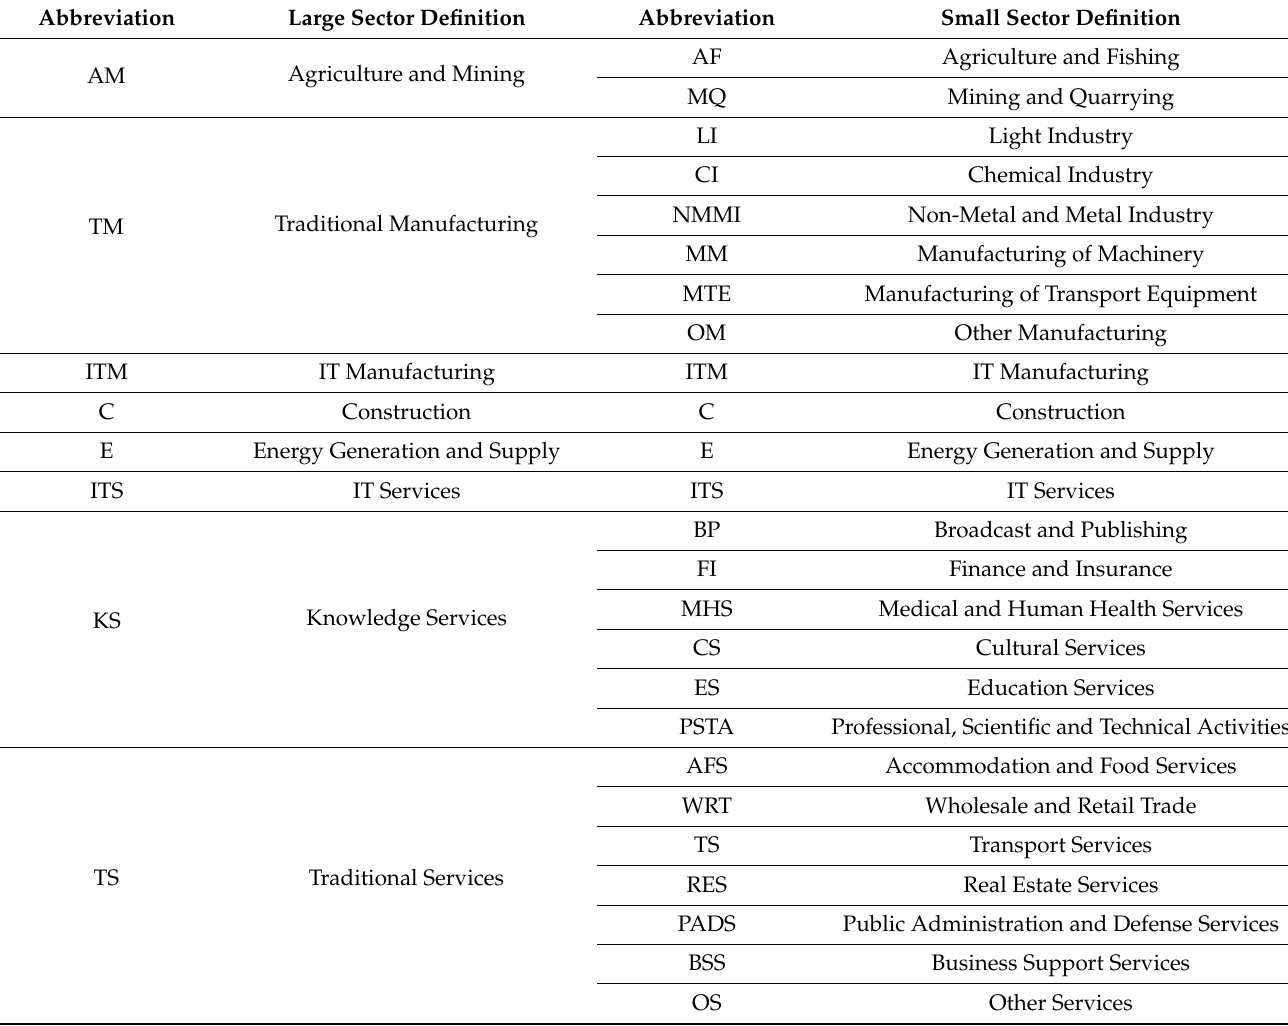
Table A3. Abbreviation